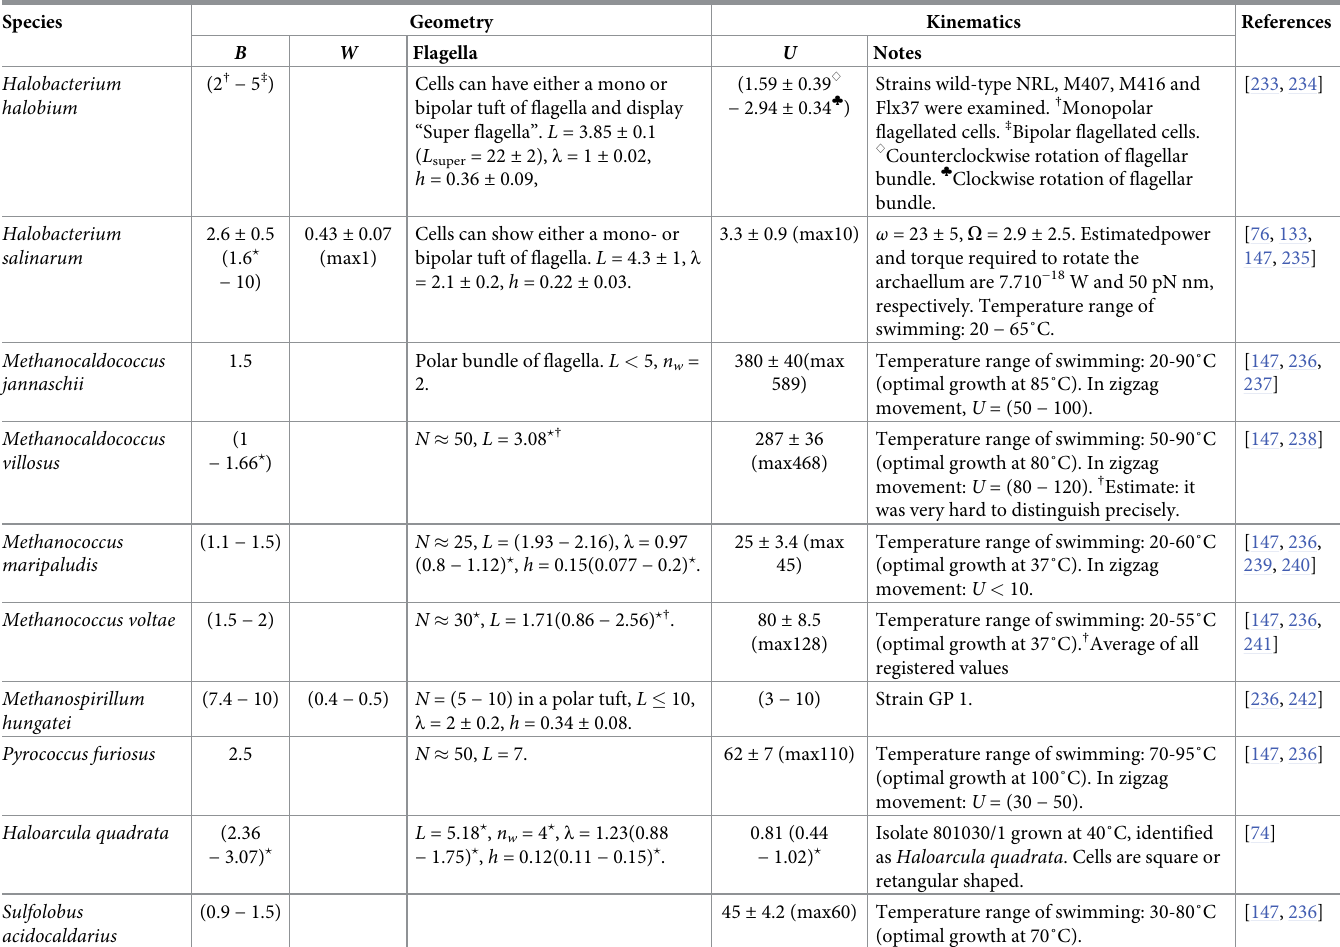
Table 6. Data for swimming Archaea. Species